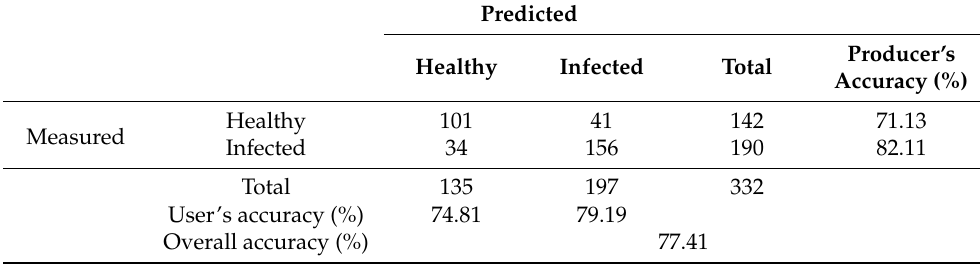
Table 4. Results of Method-SSA on 14 August